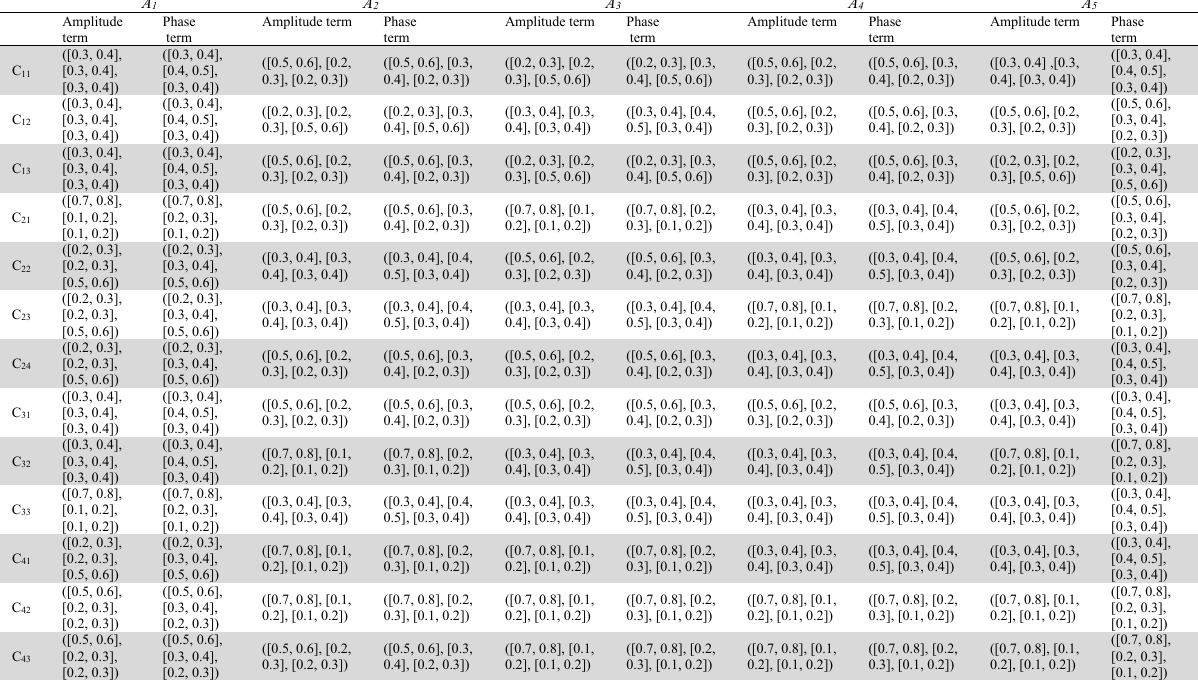
The ratings of alternatives under all criteria by decision-makers